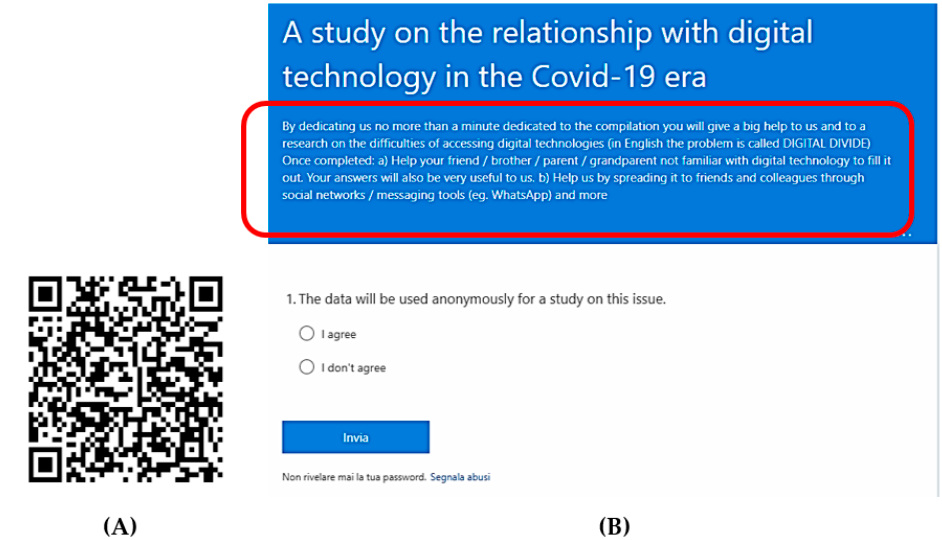
Figure 1. ( A ) The Quick Response code of the electronic survey (eS). ( B ) Request to support people who are not confident with the technology (e.g., Grandparents, parents). with the technology (e.g., Grandparents, parents).